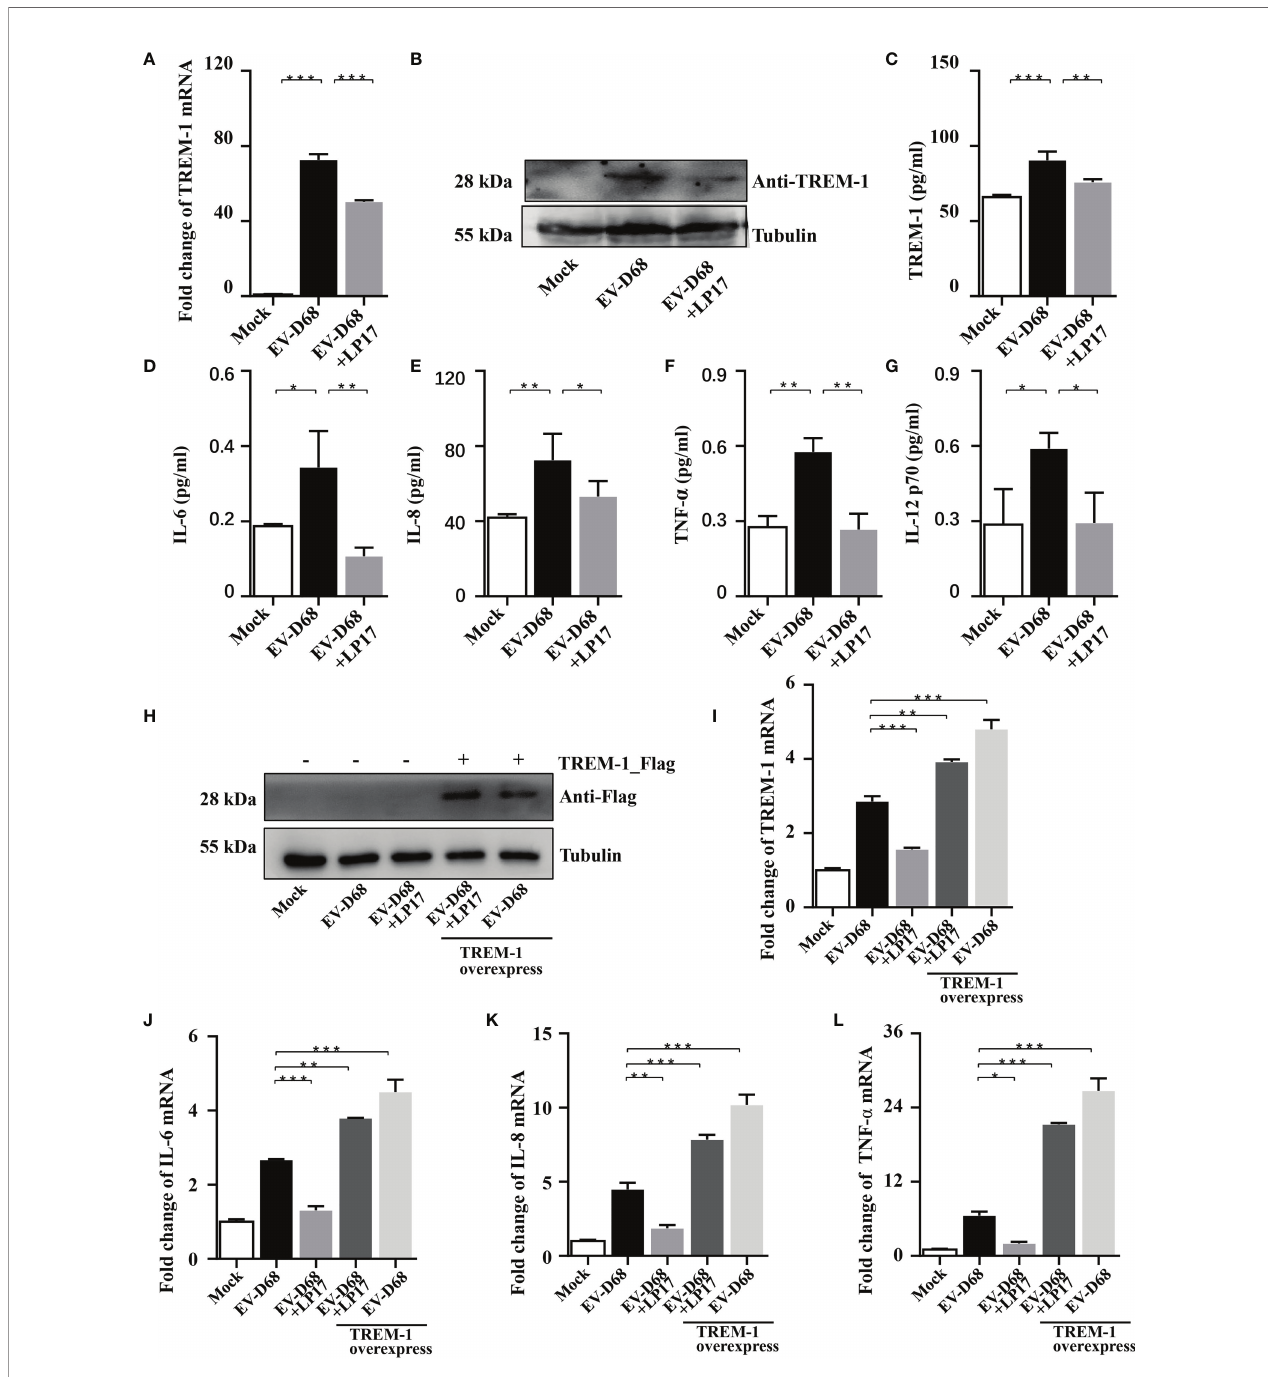
FIGURE 4 | Inhibition of TREM-1 abrogates EV-D68-mediated in fl ammatory responses. (A − C) LP17-mediated down-regulation of TREM-1 in EV-D68-infected RD cells. EV-D68-infected RD cells were pretreated with the TREM-1 inhibitor LP17 for 2 h (1 m g/ml). After 24 h, cells were harvested for subsequent experiments. TREM-1 mRNA levels were measured by RT-PCR (A). The GAPDH gene served as an internal control. The protein levels were measured by WB and ELISA (B, C) . (D − G) LP17 inhibits the expression of in fl ammatory cytokines downstream of TREM-1. RD cells in 6-well plates were infected with EVD68 (MOI = 0.1) ± LP17 (1 m g/ml). Cells were collected at 24 hpi for MILLIPLEX Multiplex Assay to quantitate changes in the levels of cytokines IL-6 (D) , IL-8 (E) , TNF- a (F) , and IL-12 p70 (G) . (H − L) TREM-1 over-expression upregulates in fl ammatory cytokine levels in virus-infected HEK293T cells. HEK293T cells were transfected with TREM-1_Flag or empty vector control (500 ng, 48-well plates) for 24 h. Cells were then infected with EV-D68 (MOI = 0.1) for 24 h, harvested for RNA extraction, and subjected to WB (H) and RT-PCR analysis of TREM-1 mRNA (I) , IL-6 (J) , IL-8 (K) , TNF- a (L) . The GAPDH gene served as an internal control, and the relative gene expression (fold change) levels of each gene were using with the comparative 2 - DD CT method. Values are means ± SD. * p < 0.05, ** p < 0.01, *** p <